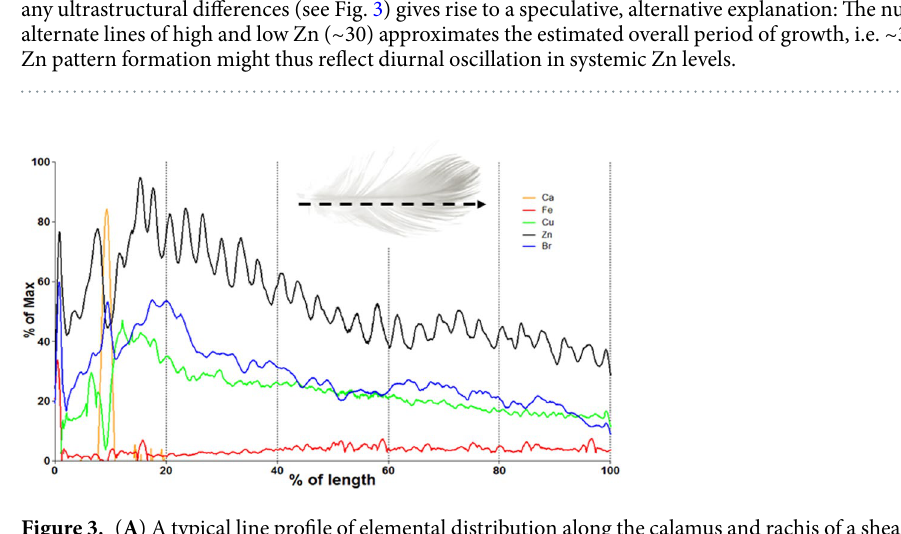
across the different species of Flesh-footed, Streaked and Short-tailed Shearwaters and did not correlate with any other visible repeating structures (Fig. 6). Calcium. Across species, calcium (Ca) showed distributions (Figs 1 and 3) with the highest concentrations con- sistently found at the calamus to skin interface. This local calcium deposition appeared to co-locate with higher concentration in copper, zinc and bromine. Otherwise, only a low and varying concentration of calcium was found across the entire the feather structure.